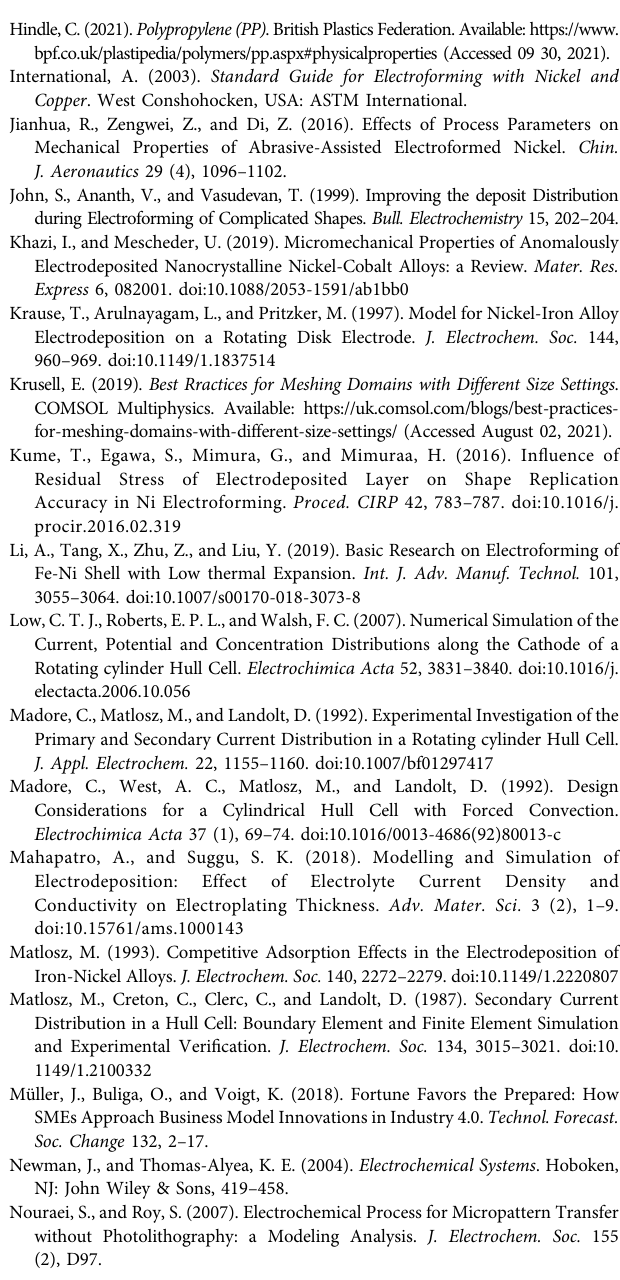
Supplementary Table S3 | Comprehensive presentation of the effect of various changes in mesh ’ s density on the thickness pro fi les modelled for both the RDE and industrial-scale